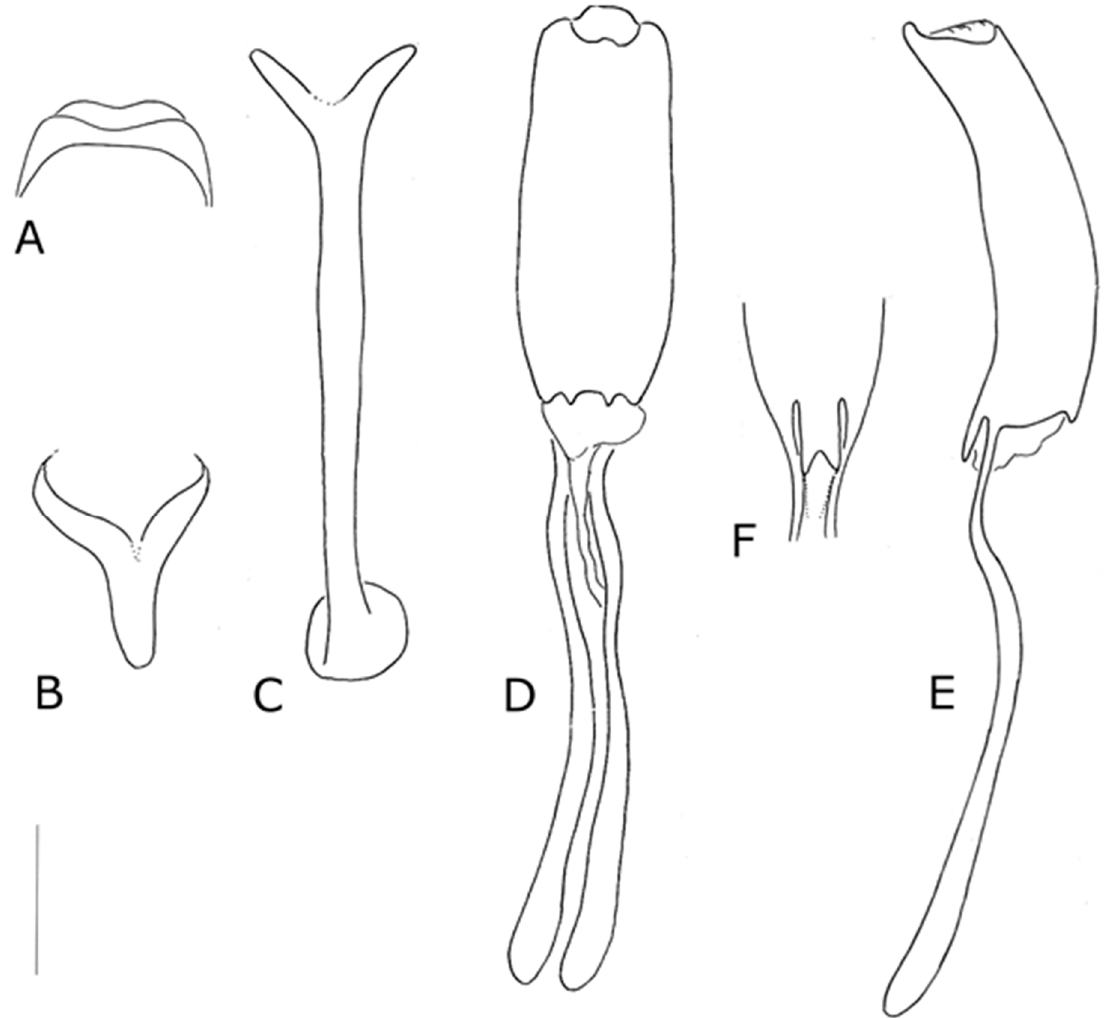
Figure 8. Sclerocardius africanus (Boheman), male terminalia: ( A ) sternite VIII, ventral, ( B ) tegmen, dorsal, ( C ) spiculum gastrale, ventral, ( D ) penis, dorsal, ( E ) penis, lateral, and ( F ) penis, anterior ventral margin. Scale bar = 1 mm.